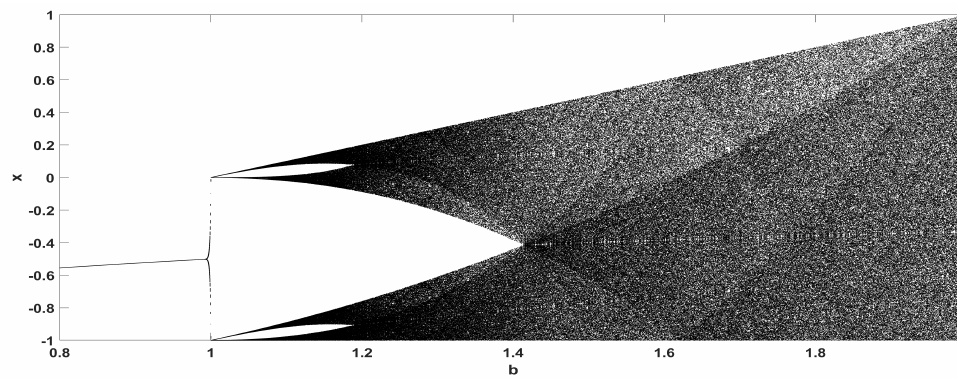
Figure 7. Bifurcation diagram with respect to parameter b , for a = 1, r = 1.